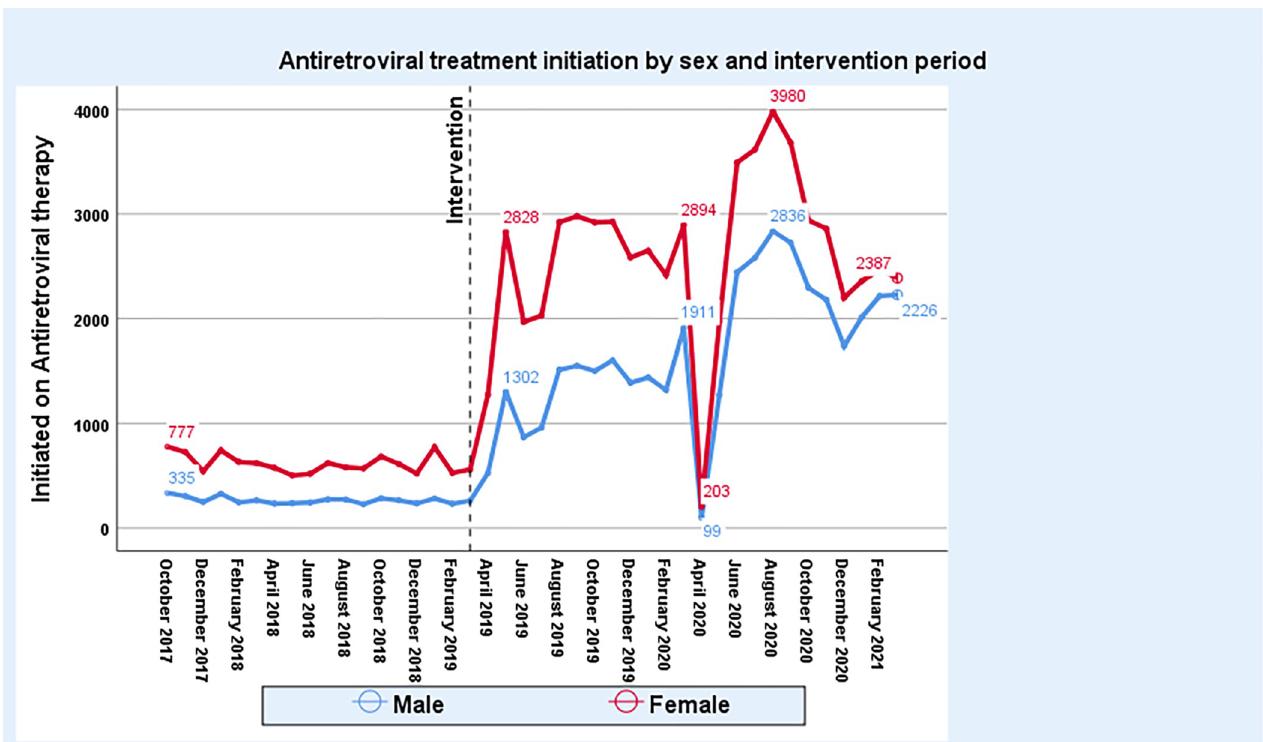
Fig 3. Number of people initiated on ART October 2017-February